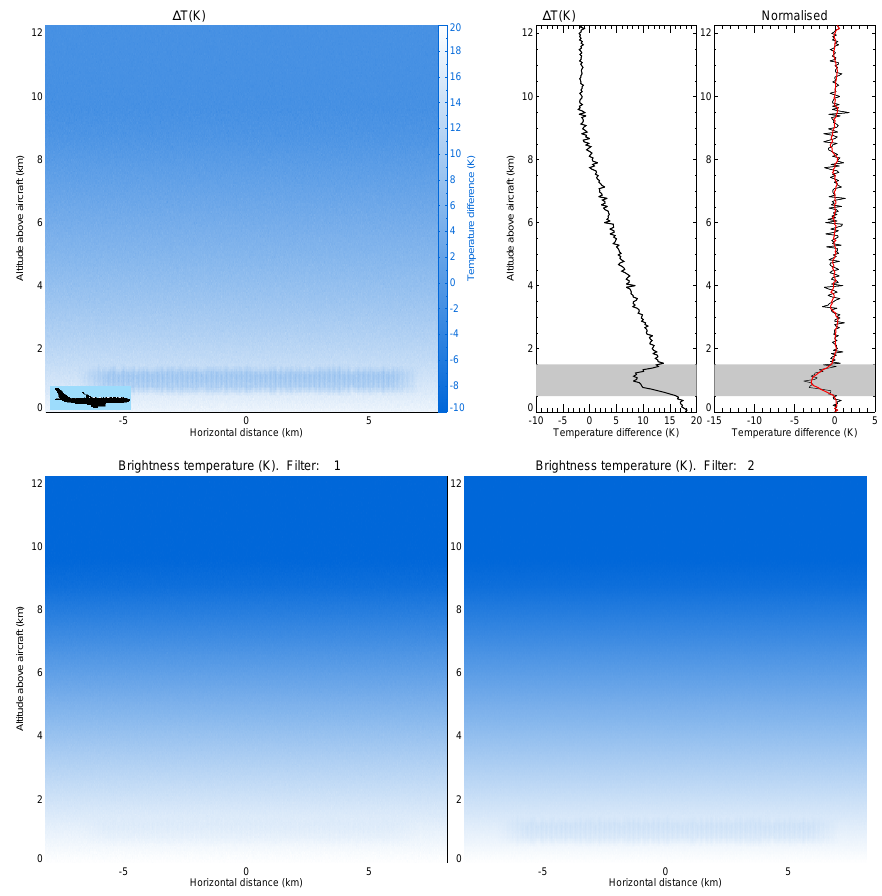
Figure 10. As for Figure 9 but using an optimised channel selection. The detection is superior and the anomaly signal is above the noise level.